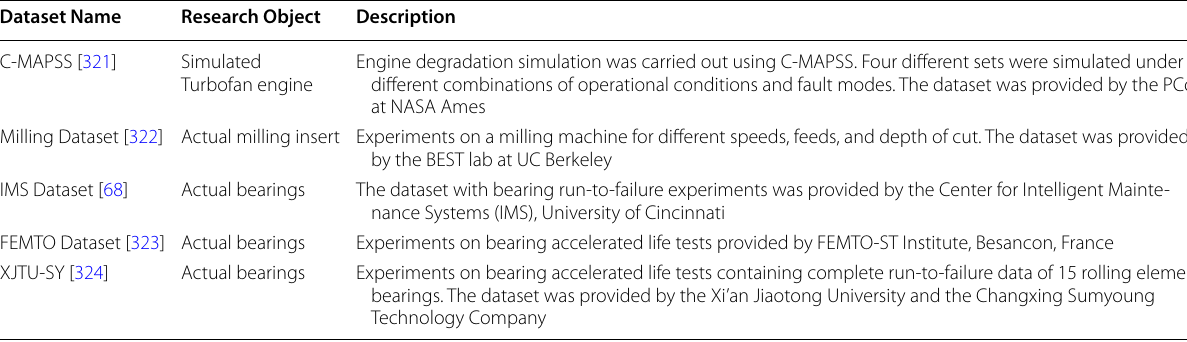
Table 4 Publications about the application of CNN in fault